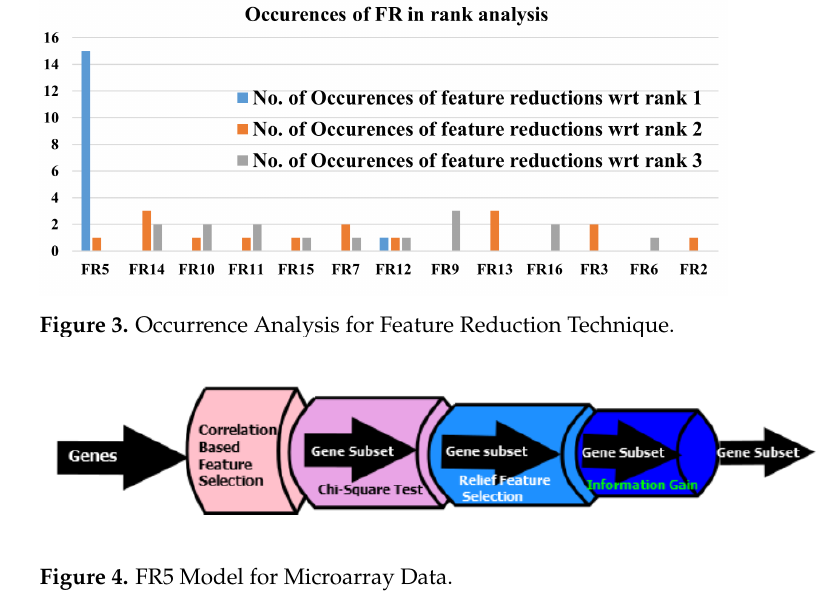
Figure 4. FR5 Model for Microarray